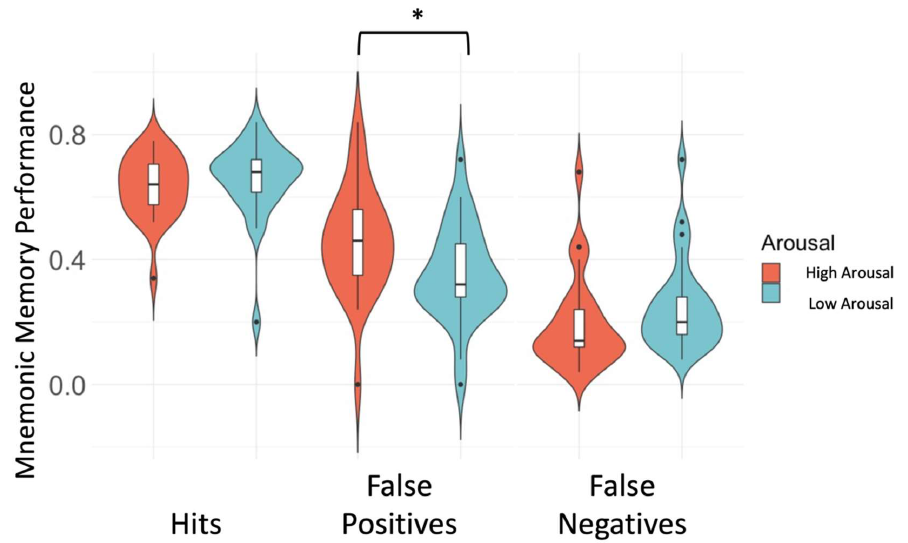
Figure 2. Memory performance under high and low arousal. More False Positives were observed for high arousal trials compared to low arousal trials. No differences were observed for Hits and False Negatives. Y-axis equals the mean proportion of Hits, False Positives, and False Negatives. Boxplots reflect the median and inter quartile range * p < 0.05.